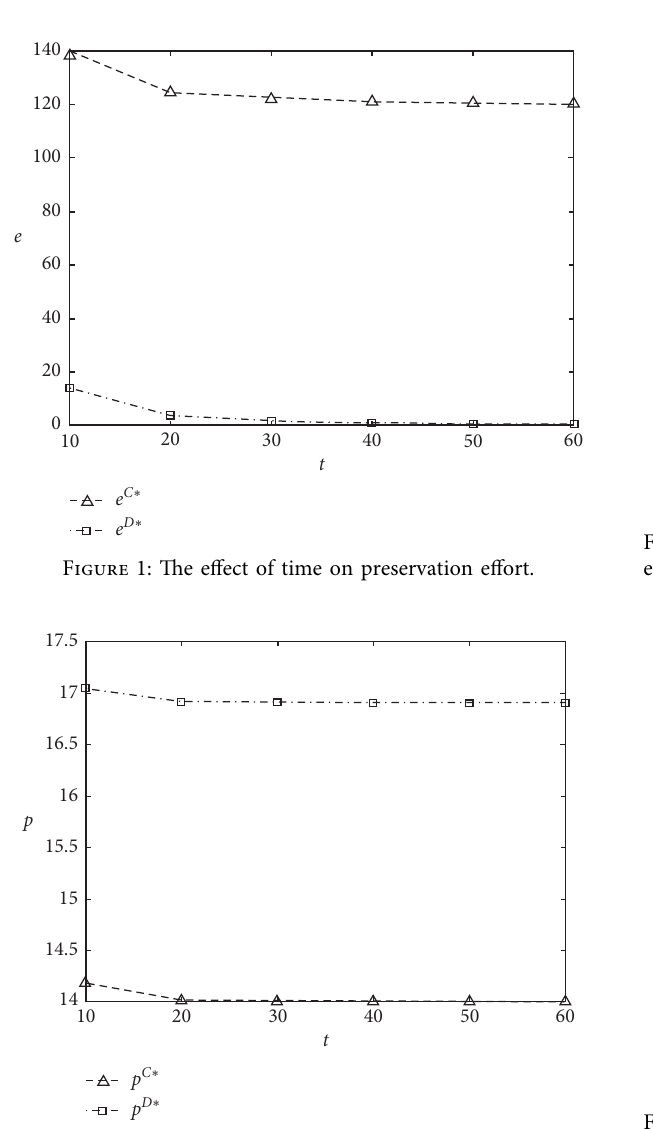
Figure 2: The effect of time on sales prices.